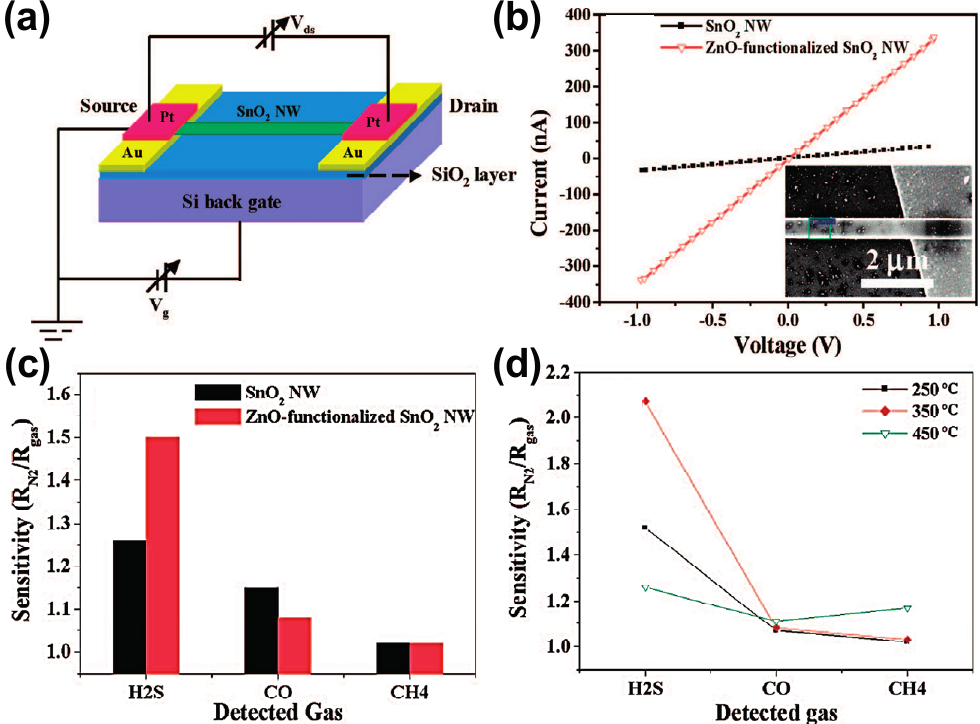
nanowire-based FET; ( b ) I - V curves Figure 4. ( a ) Schematic illustration of a single SnO 2 of the single SnO nanowire device before and after ZnO deposition. The inset is the 2 nanowire device after ZnO deposition; corresponding SEM image of the single SnO 2 ( c ) Comparison of gas-sensing sensitivity of the pure and ZnO-functionalized SnO 2 nanowire sensor to three detected gases; ( d ) Sensitivity to three detected gases of the nanowire sensor at different operation temperatures. The ZnO-functionalized SnO 2 concentration of detected gases was 500 ppm, the operation temperature was 250 °C, and the fixed bias was 1 V